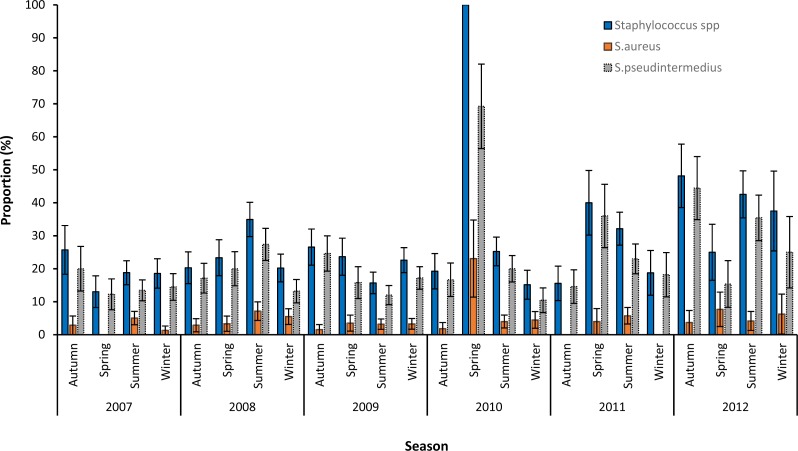
Seasonal patterns in the proportions and 95% confidence intervals of Staphylococcus infections among canine samples tested at the academic veterinary hospital, 2007–2012.